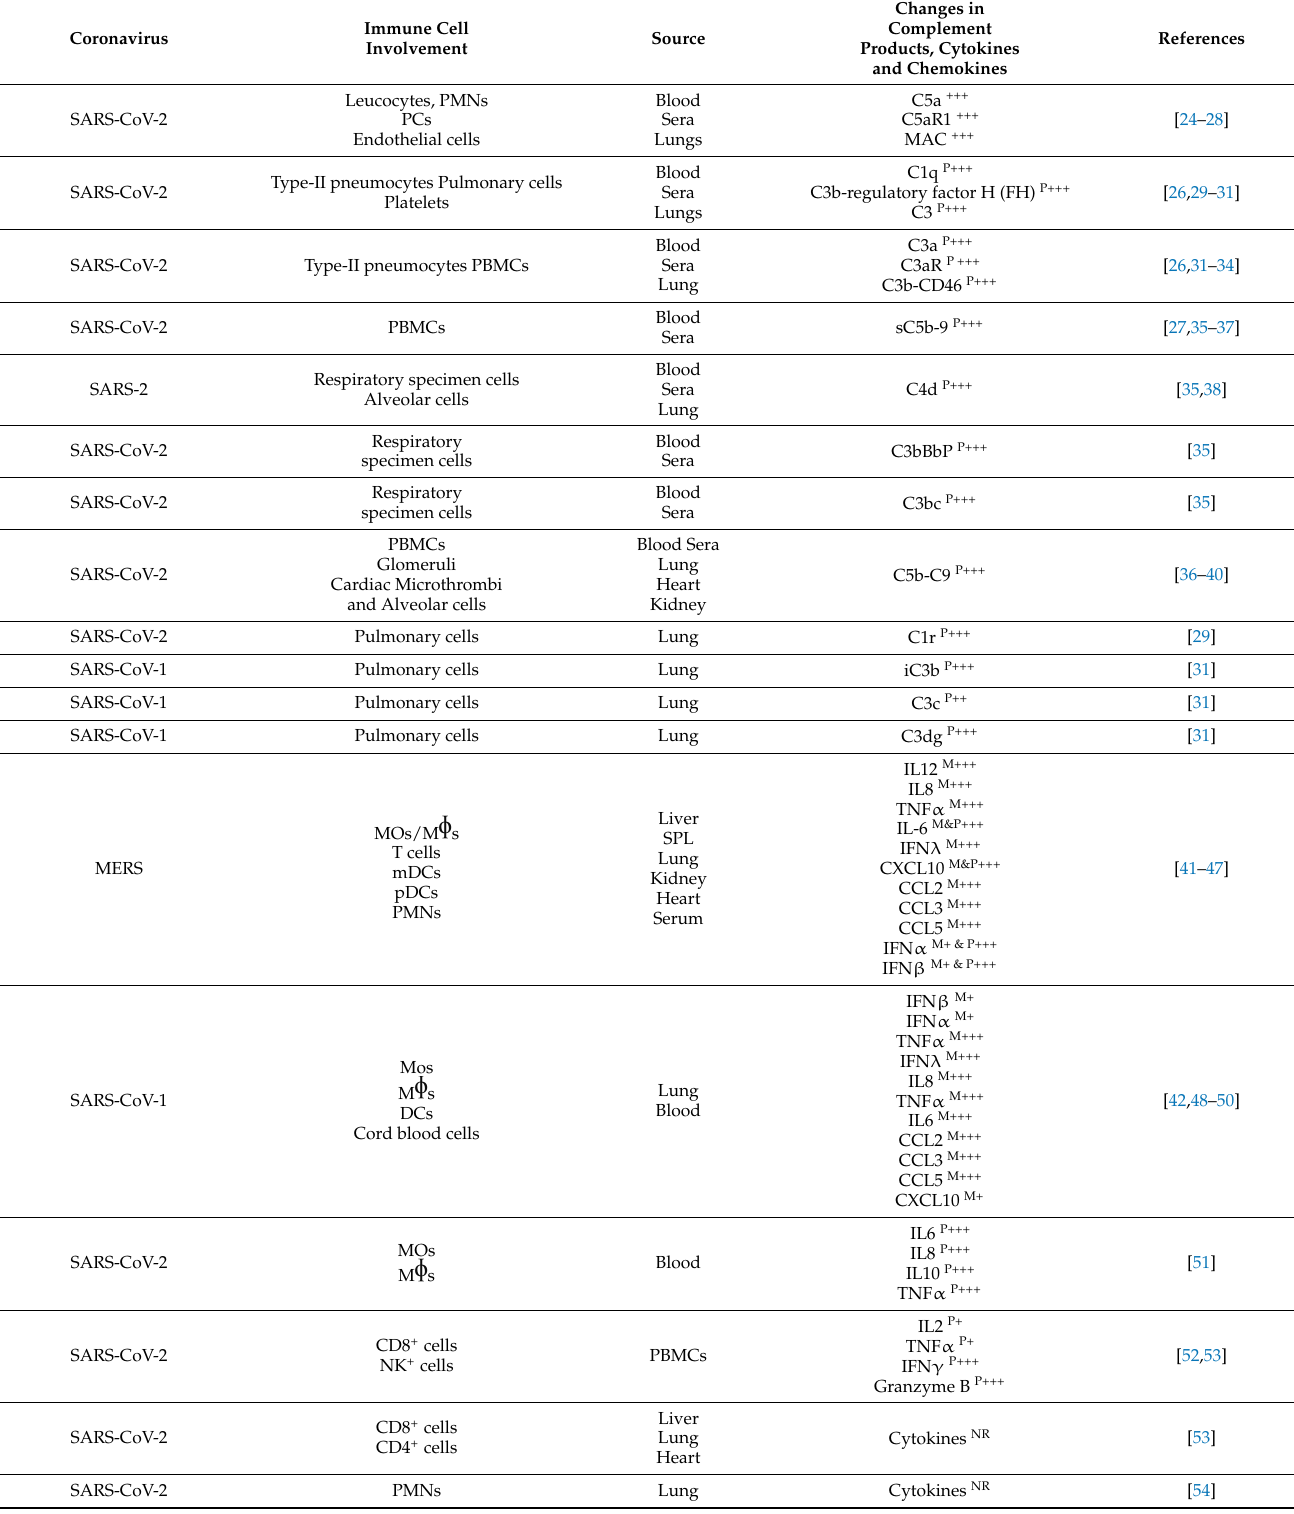
Table 1. Immune cells and their effector inflammatory mediators in